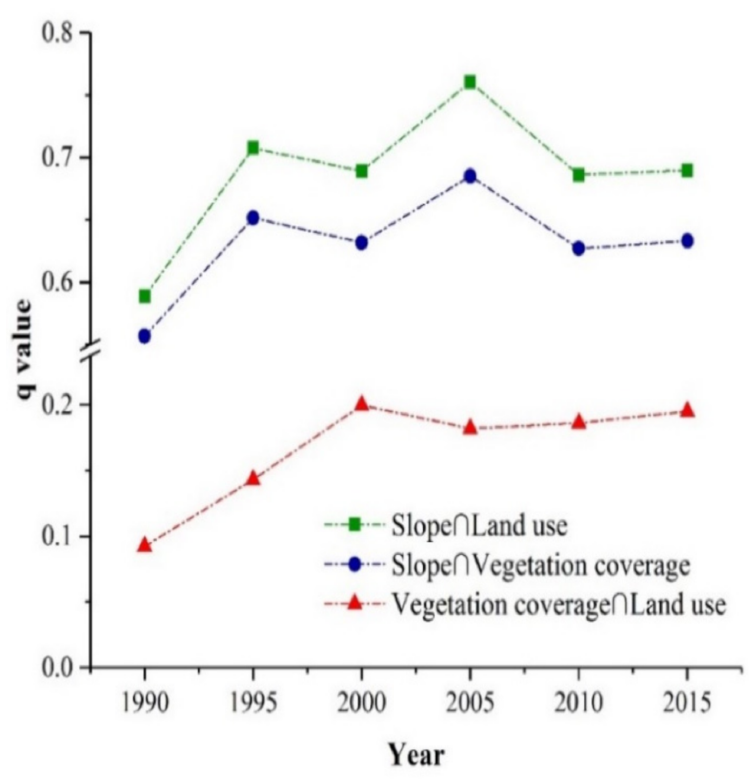
Figure 9. The three most dominant interaction factors in the TGRA between 1990 and